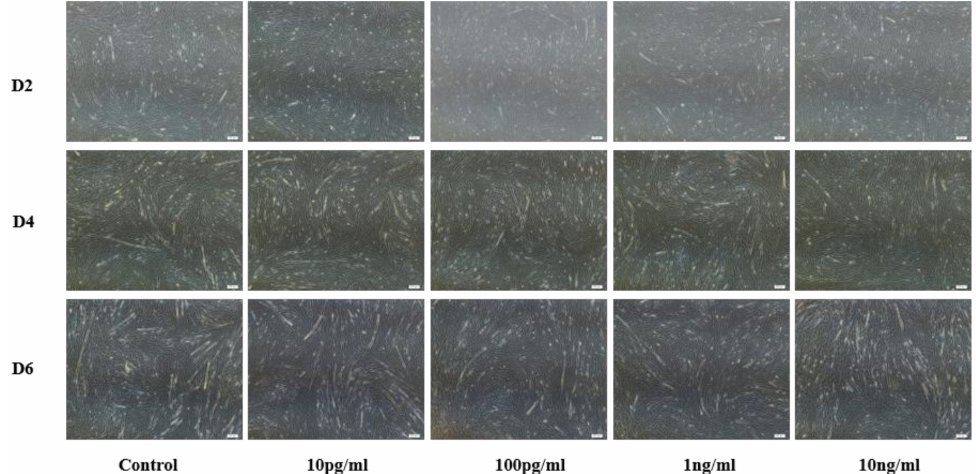
Figure 2. Effects of NENF with different concentrations of myoblast differentiation. Morphological changes of differentiating bovine skeletal primary myoblasts after adding the recombinant protein NENF and PBS at the 2nd day of natural differentiation (D2), 4th day of natural differentiation (D4) and the 6th day of natural differentiation (D6). (OLYMPUS IX71 40 ×